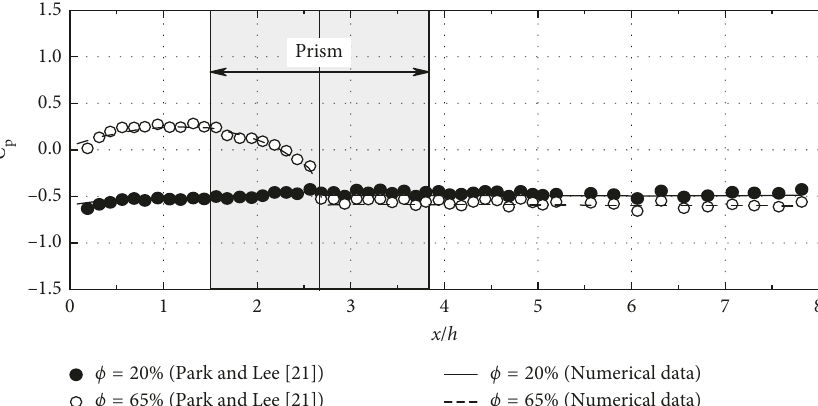
Figure 4: Schematic sketch of the computational domain and coordinate system of the fence and prism.